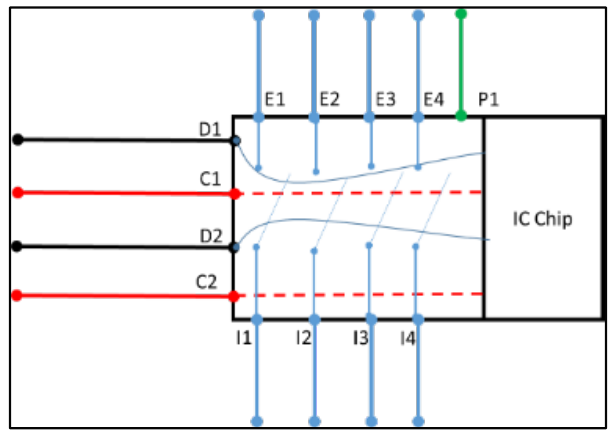
Figure 3. Component of MUXER.